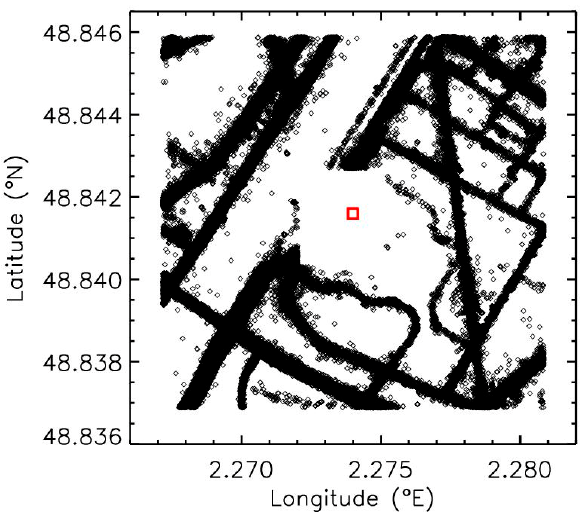
Figure 9. Location of the Pollutrack measurements (small diamonds) and position of the LOAC instrument red Scheme 27 March 2019–26 March 2020 period.